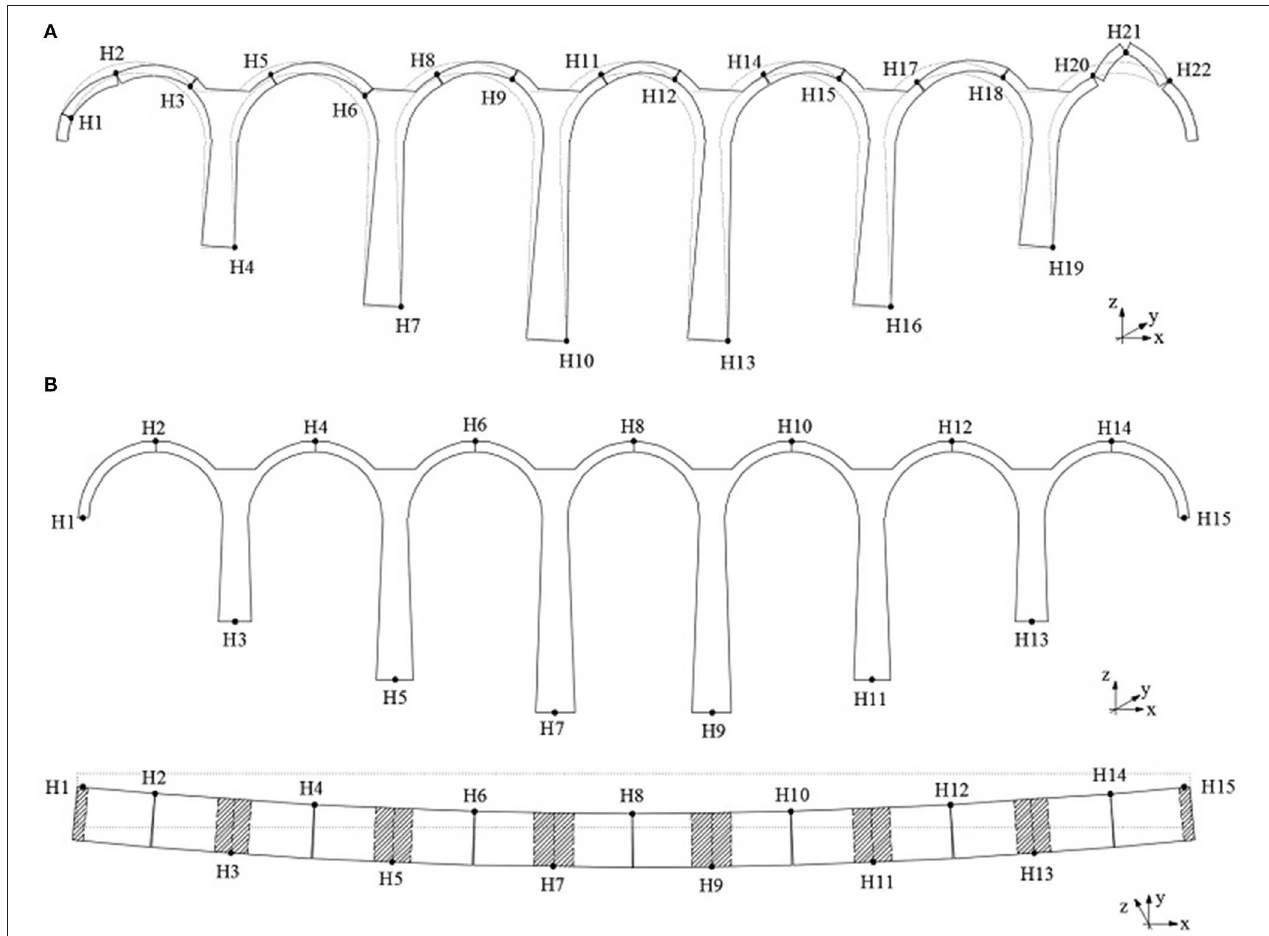
FIGURE 3 | Collapse mechanisms of the bridge. (A) Longitudinal collapse mechanism. (B) Transversal collapse